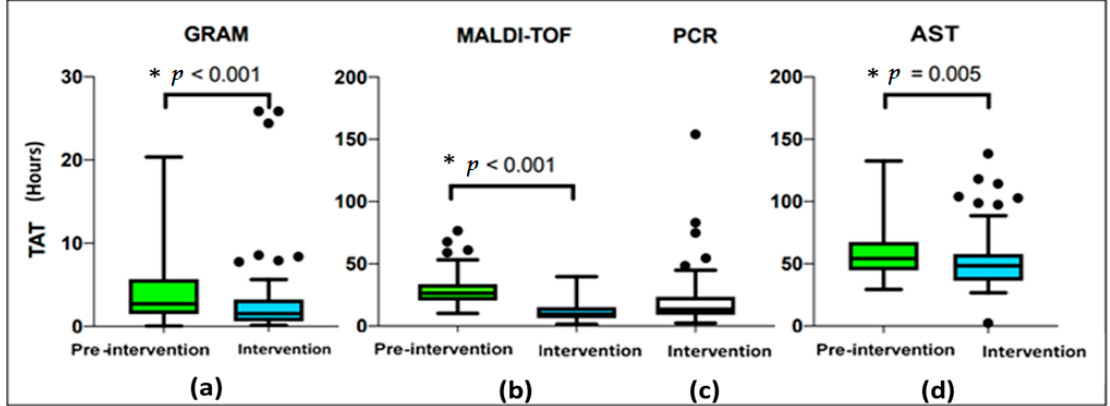
Figure 2. TAT: Turnaround time between pre-intervention and intervention period. ( a ): GRAM: time from bacteria detection until Gram stain. ( b ): MALDI-TOF: time from bacteria detection until MALDI- TOF. ( c ): PCR: time from bacteria detection until PCR for the intervention group only. ( d ): AST: time from bacteria detection until antimicrobial susceptibility test. *: Mann–Whitney